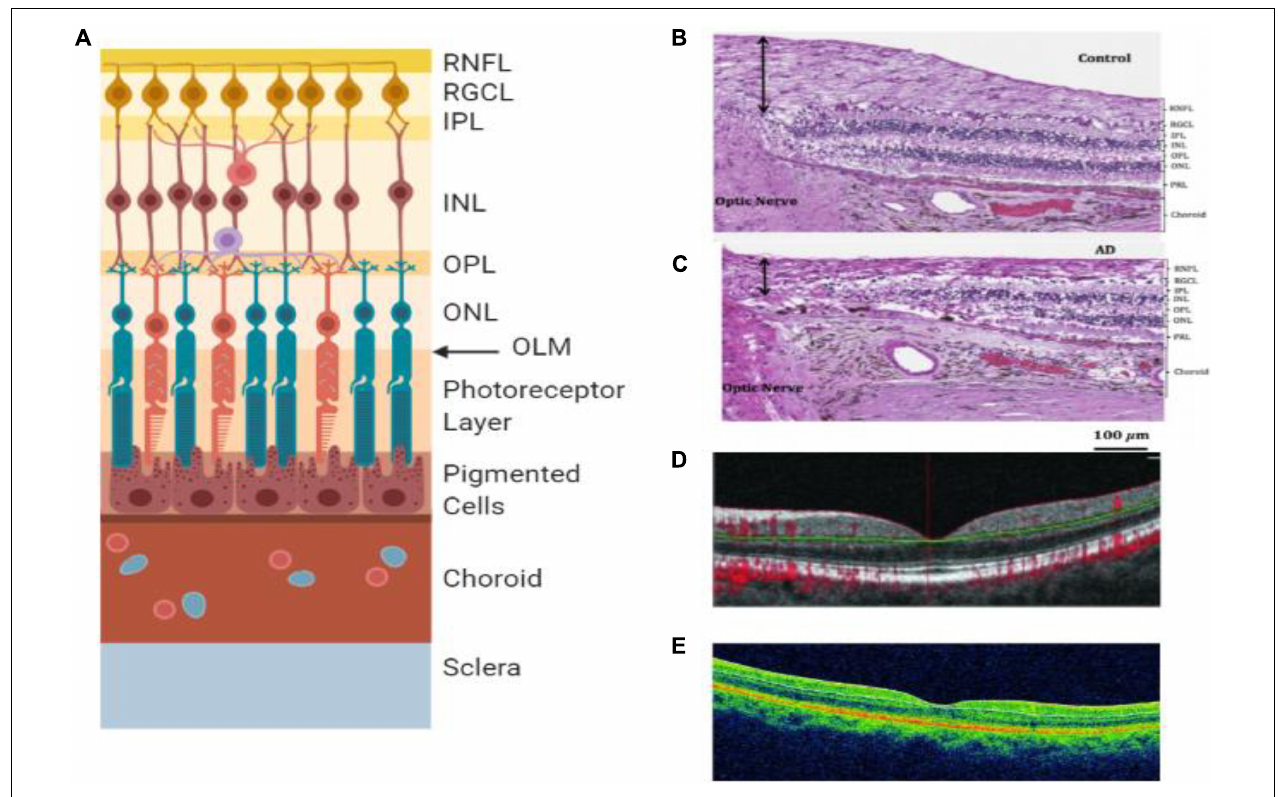
FIGURE 4 | Retinal layers and imaging. (A) The individual layers of the retina. (B) Light microscopy image of human post-mortem control retina stained with hematoxylin and eosin. The black arrow represents the superior-temporal RNFL thickness (Asanad et al., 2019). (C) Light microscopy image of human post-mortem AD retina stained with hematoxylin and eosin. The black arrow represents the superior-temporal RNFL thickness and demonstrates the most thinning close to the optic nerve (Asanad et al., 2019). (D) OCT of preclinical AD patient (O’Bryhim et al., 2018). (E) OCT of a retina with clinical AD (Cunha et al., 2017). RNFL = retinal nerve fiber layer, RGCL = retinal ganglion cell layer, IPL = inner plexiform layer, INL = inner nuclear layer, OPL = outer plexiform layer, ONL = outer nuclear layer, OLM = outer limiting membrane, AD = Alzheimer’s disease, PRL = photoreceptor